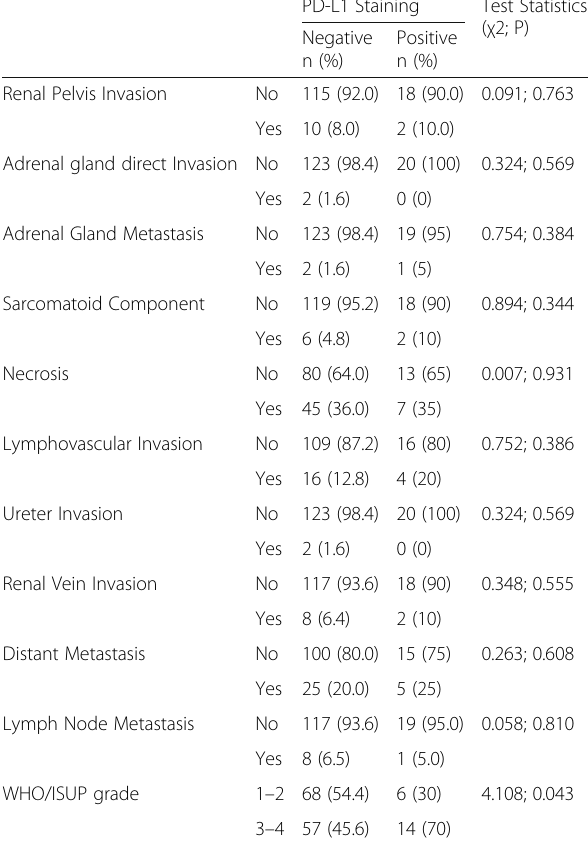
Table 3 Summary of clinicopathologic prognostic factors according to the PD-L1